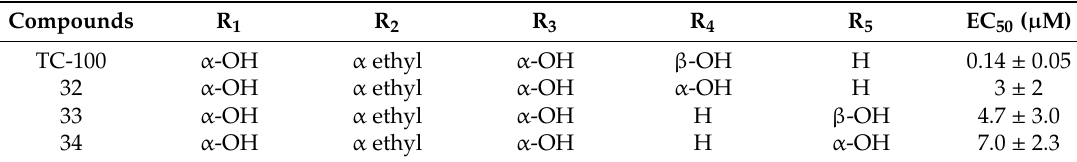
Figure 4. 2D image of the changes to bile acids sca ff old reported in Table 3. Table 3. Modifications made on bile acids sca ff old.